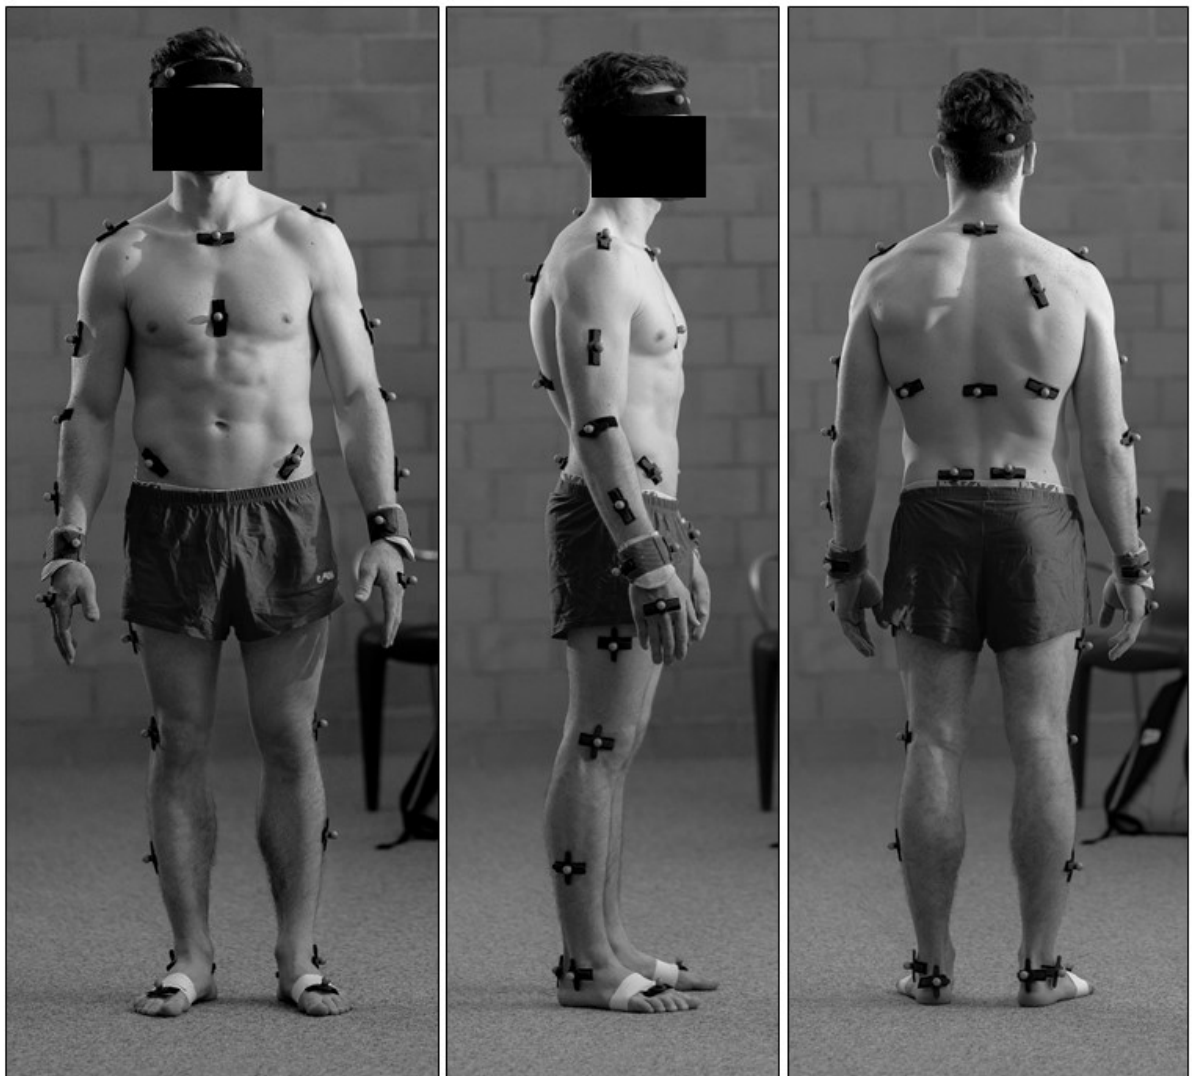
Figure 3. Positioning of the reflective markers used for 3-dimensional motion capture analysis according to the Vicon Plug-In Gate model (Vicon, 2010).